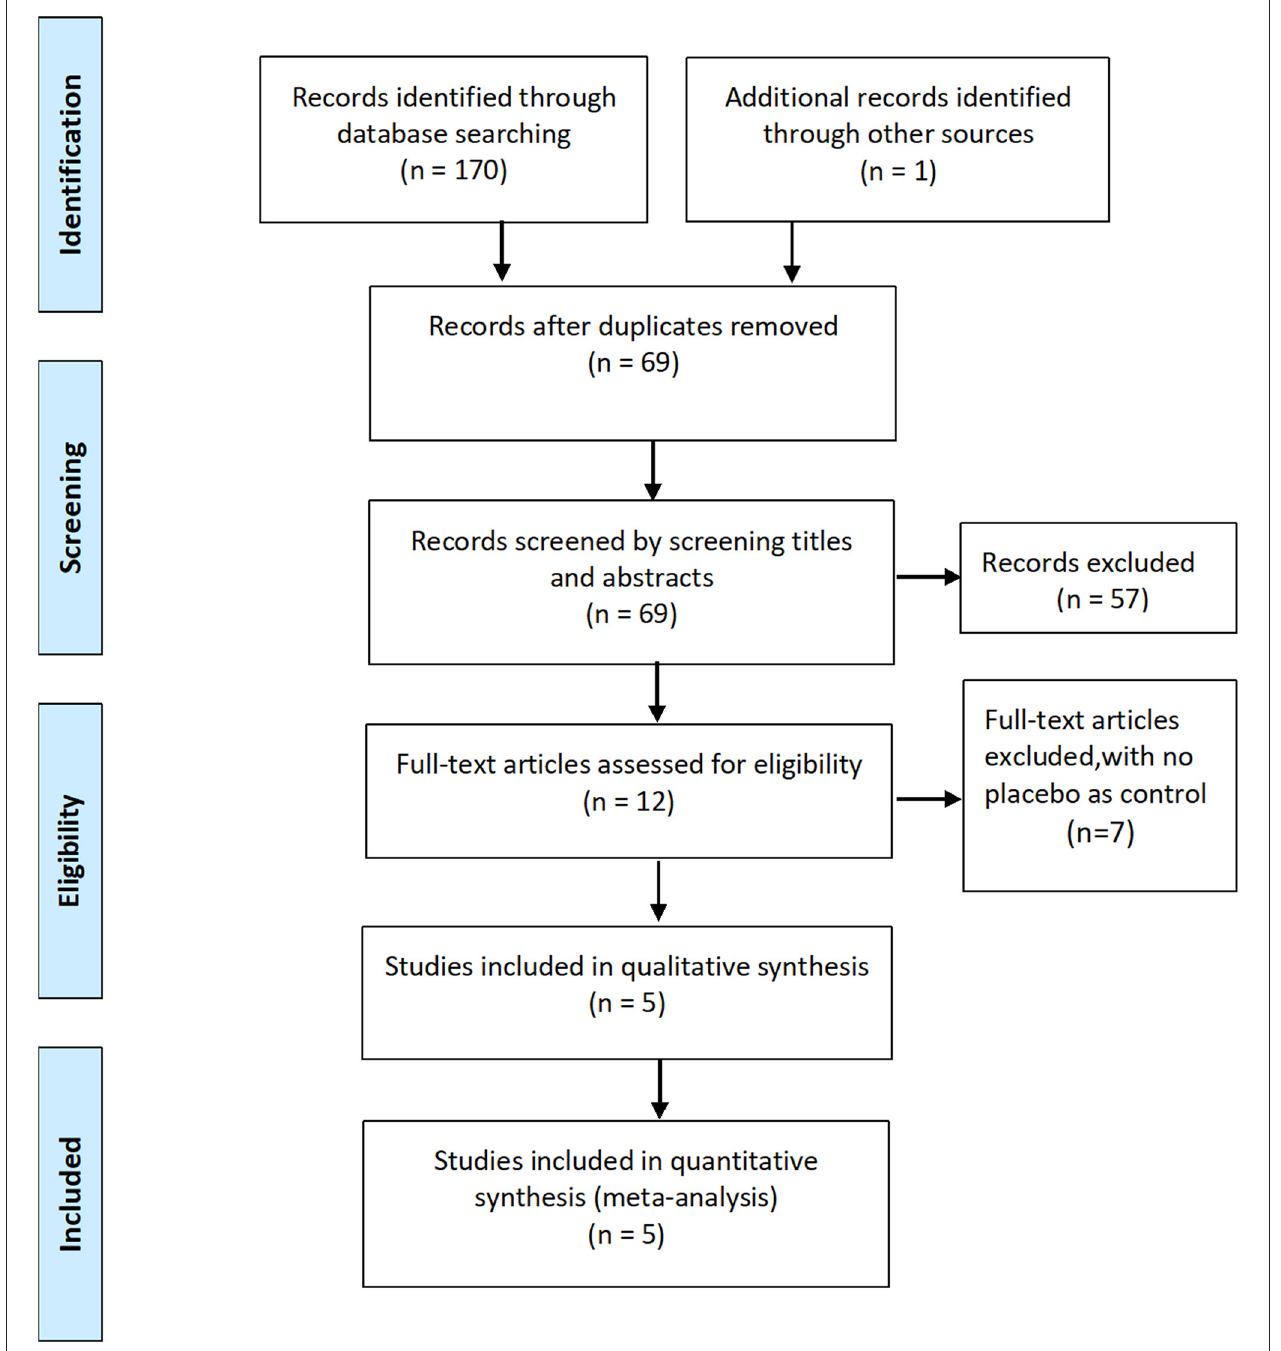
FIGURE 1 | Flow diagram of study selection.